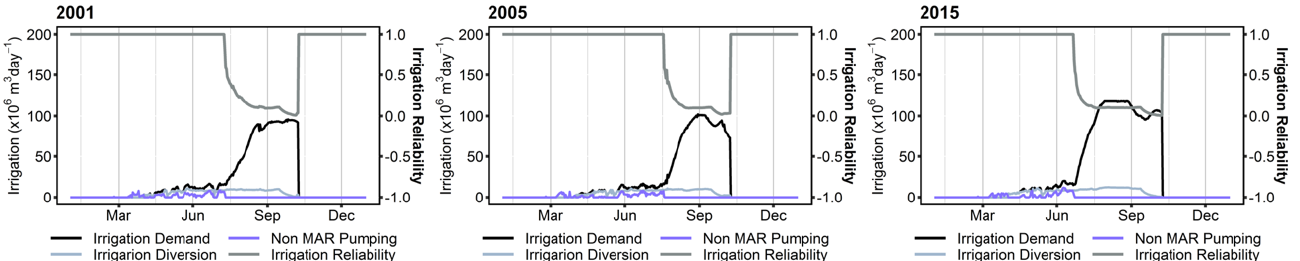
Figure 10. Irrigation water (demand, diversion, and non-MAR pumped) and reliability without MAR implementation for drought years 2001, 2005, and 2015.